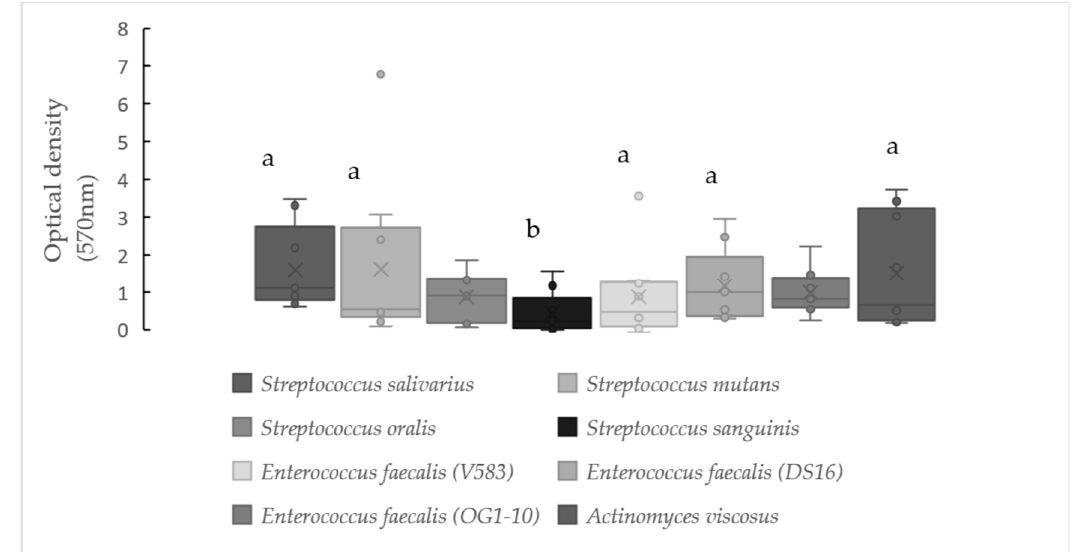
Figure 1. Biofilm production by pure cultures, observed after growth in Brain Hear t Infusion (BHI) with mucin at 37 °C for 48 h. Strains that do not share a common letter show a significantly different biofilm production capabilities ( p < 0.05). The lower and upper limits of the box are the first and third quartiles, respectively, median (central horizontal bar), mean (cross) and whiskers’ upper and lower bounds (vertical lines), and outliers (point) are values that fall outside of the adjacent value region.